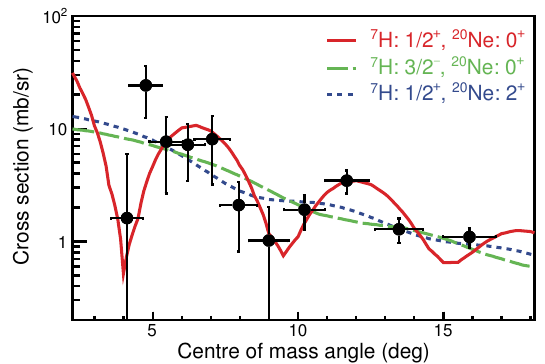
Figure 5. Di ff erential cross section of the 19 F( 8 He, 7 H) 20 Ne transfer channel. The experimental data set (black dots) is well reproduced by a DWBA calculation of the transfer reaction pro- ducing a 7 H resonance in a 1 / 2 + level and a 20 Ne in its 0 + ground state (red line). Other plausible scenarios (green and blue lines) do not follow the measured